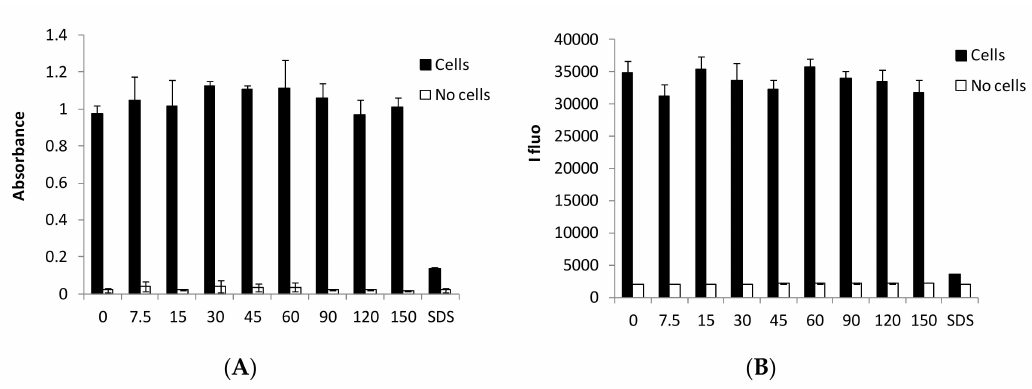
Figure 6. Cytotoxicity of the PLA-b-P(NIPAAm-co-PEGMA) copolymer towards dendritic cells (DC 2.4) at various concentrations (7.5 to 150 µ g · mL − 1 ) assessed by MTT ( A ) and Presto Blue ( B ) assays. “0” means no polymer (signal of cell alone is the one on which the results are normalized to calculate cell viability). Sodium dodecyl sulfate (SDS) (right) was used as a toxic positive